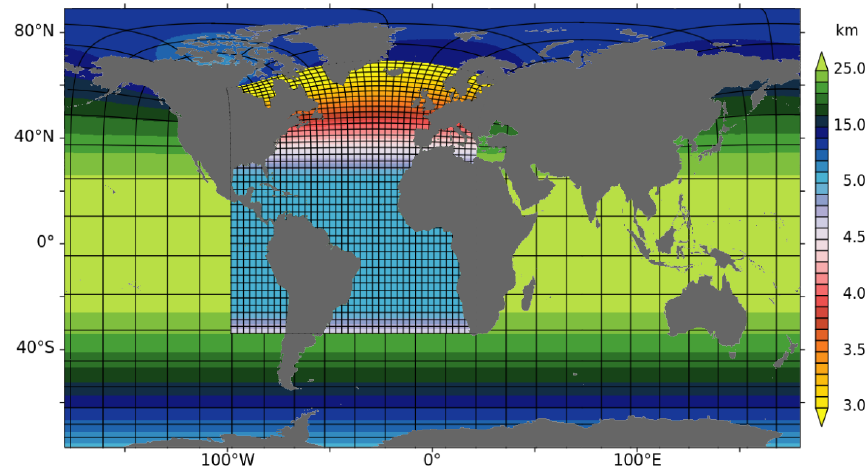
Figure 1. Domain and resolution (in km) of the VIKING20X configuration. The nest area is marked by increased resolution ranging from 5 to 3km embedded into a global ORCA025 host grid (for both grids every 60th grid line is shown in x and y directions). In total, the horizontal grid of VIKING20X consists of 1442 × 1021 cells on the host grid plus 2404 × 2499 cells on the nest